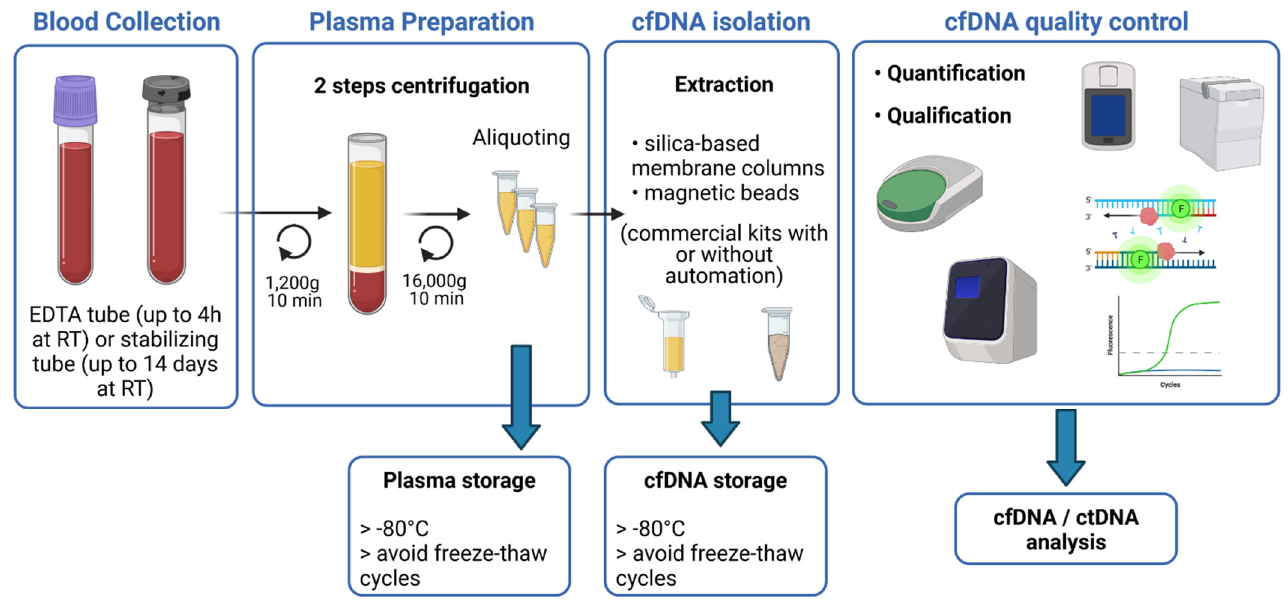
Figure 1. Schematic overview of the main steps for blood sample processing and cfDNA extraction. Blood, collected in EDTA or stabilizing tubes, goes through two rounds of centrifugation to obtain plasma samples. CfDNA is isolated from plasma using commercial kits and is quantified and qualified for further analysis.